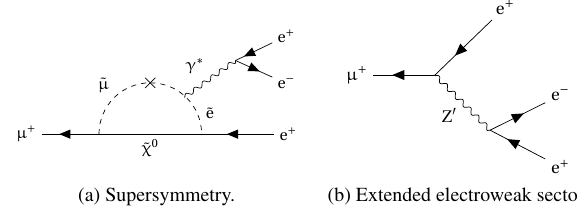
Figure 1: The decay µ → eee in extensions of the Standard